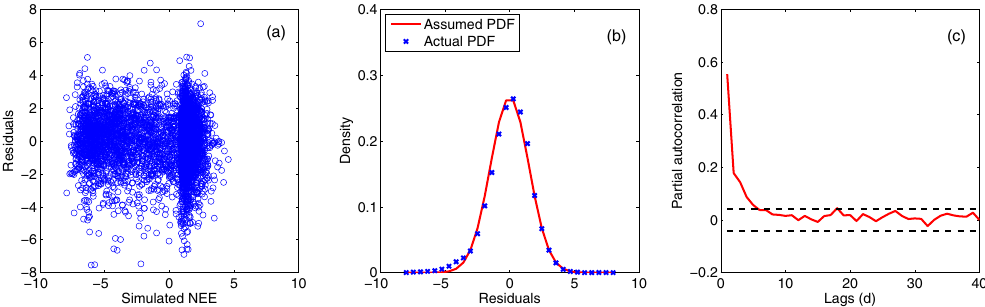
Figure 10. Residual analysis of the calibration using Gaussian likelihood with heteroscedastic and uncorrelated errors: (a) residuals vs. simulated NEE; (b) assumed and actual probability density functions of residuals; and (c) partial autocorrelation coefficients of residuals with 95% significance levels (black dashed